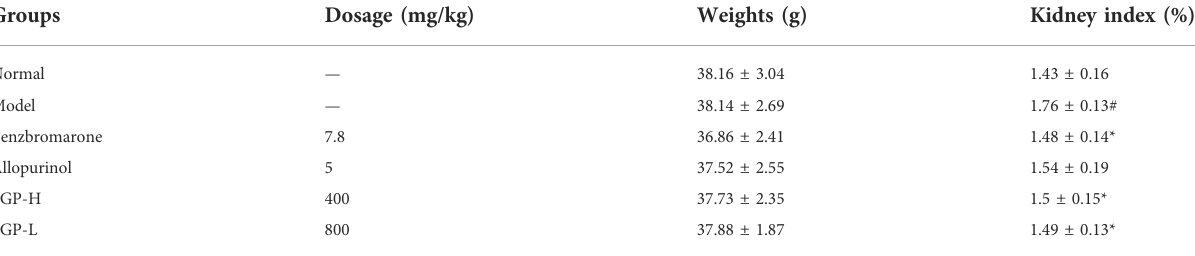
TABLE 3 Effects of FGP on organ index of HUA mice.